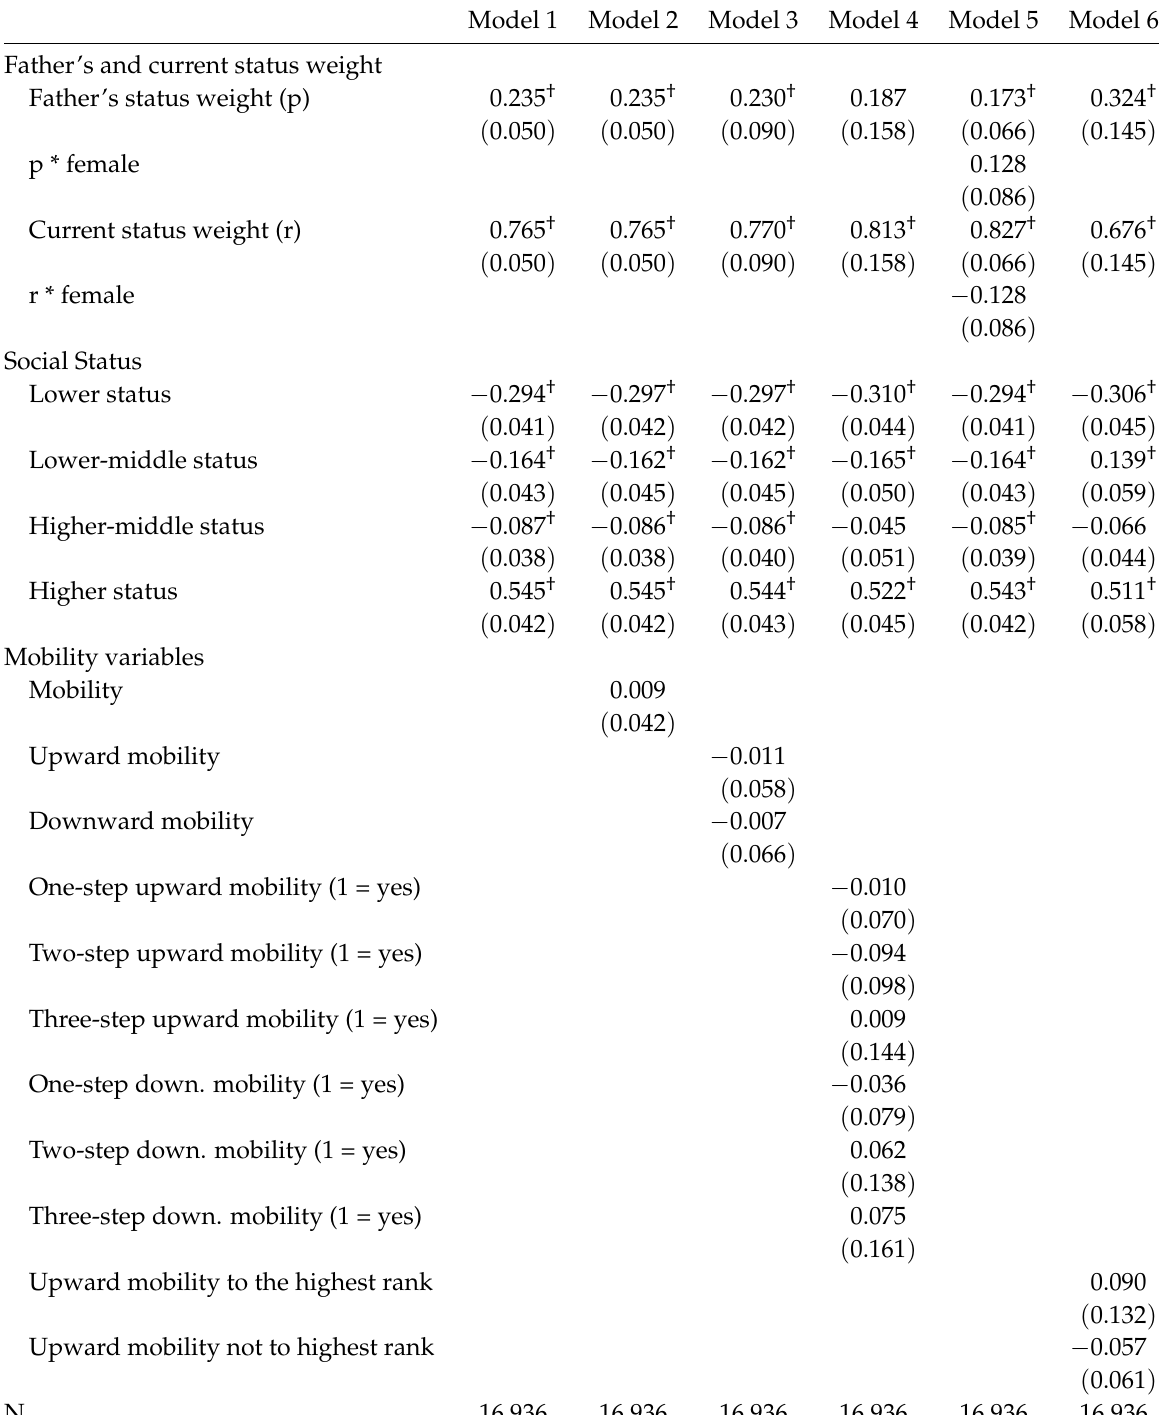
Table 5: Intergenerational estimates from diagonal mobility models predicting